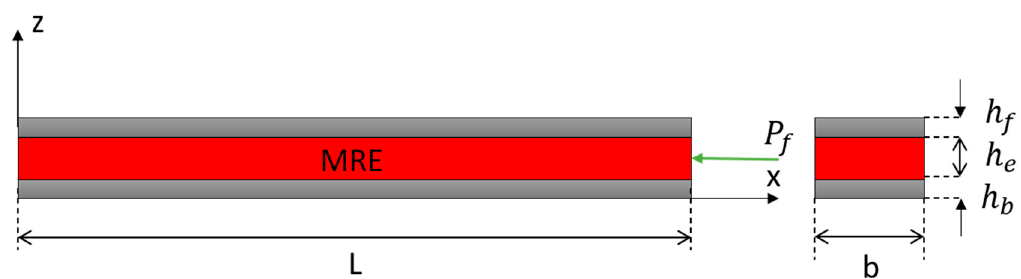
Figure 4. Sandwich beam with MRE